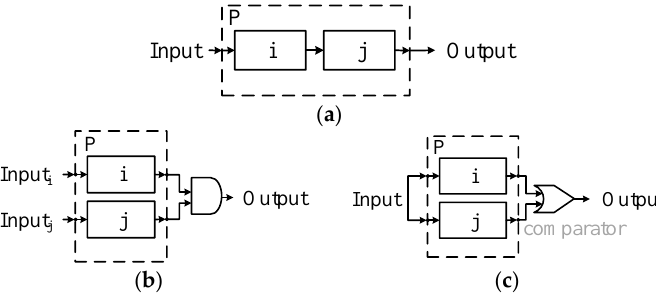
Figure 14. The basic pattern of composition. ( a ) Serial composition; ( b ) Functional parallel composition; ( c ) Redundant composition.